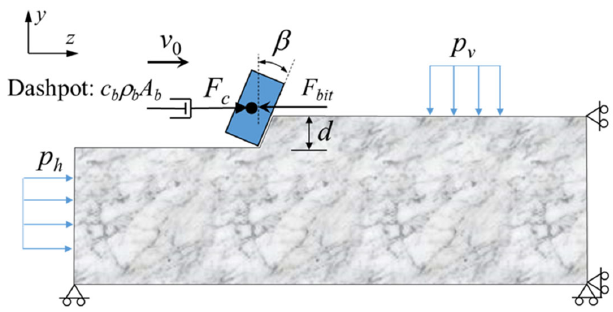
Figure 2. Schematic for PDC cutting simulation model.